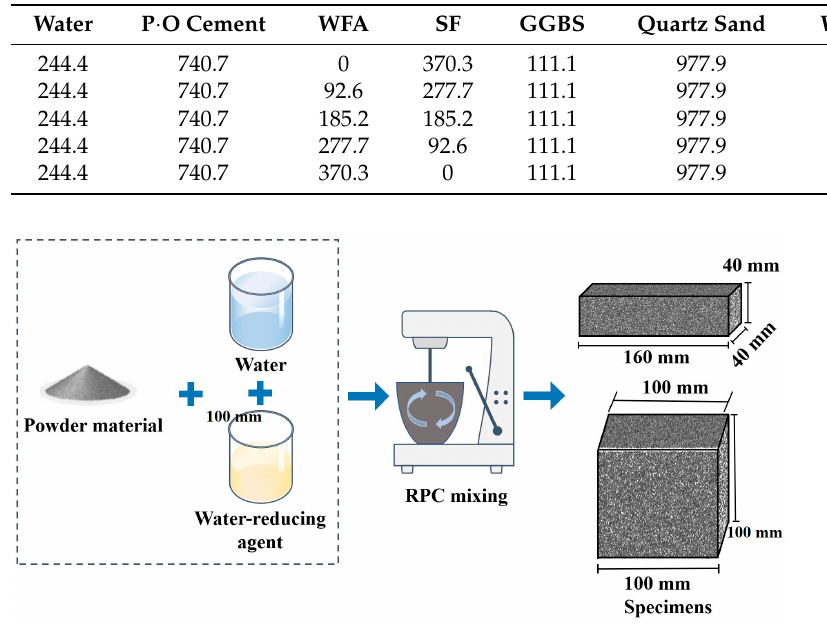
Figure 1. The manufacturing process of RPC specimens.